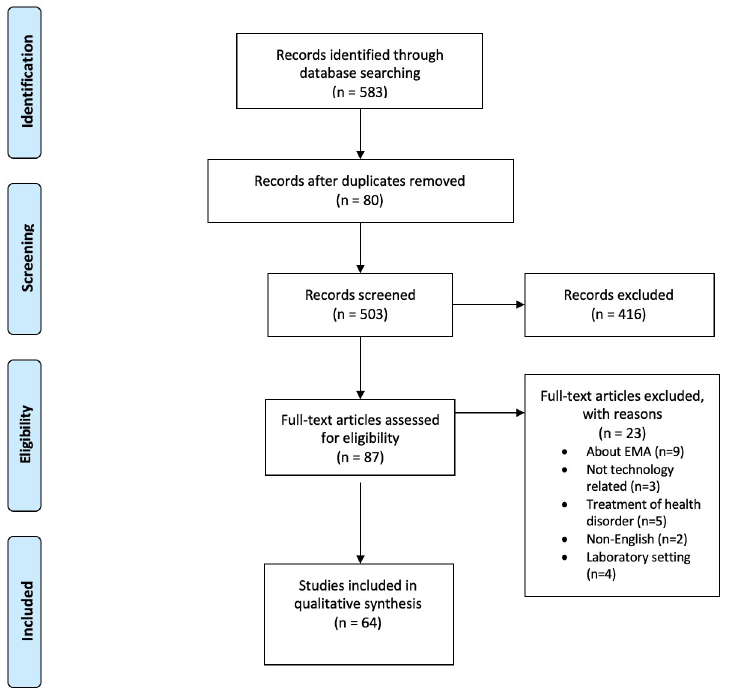
Fig 1. Flow diagram for paper